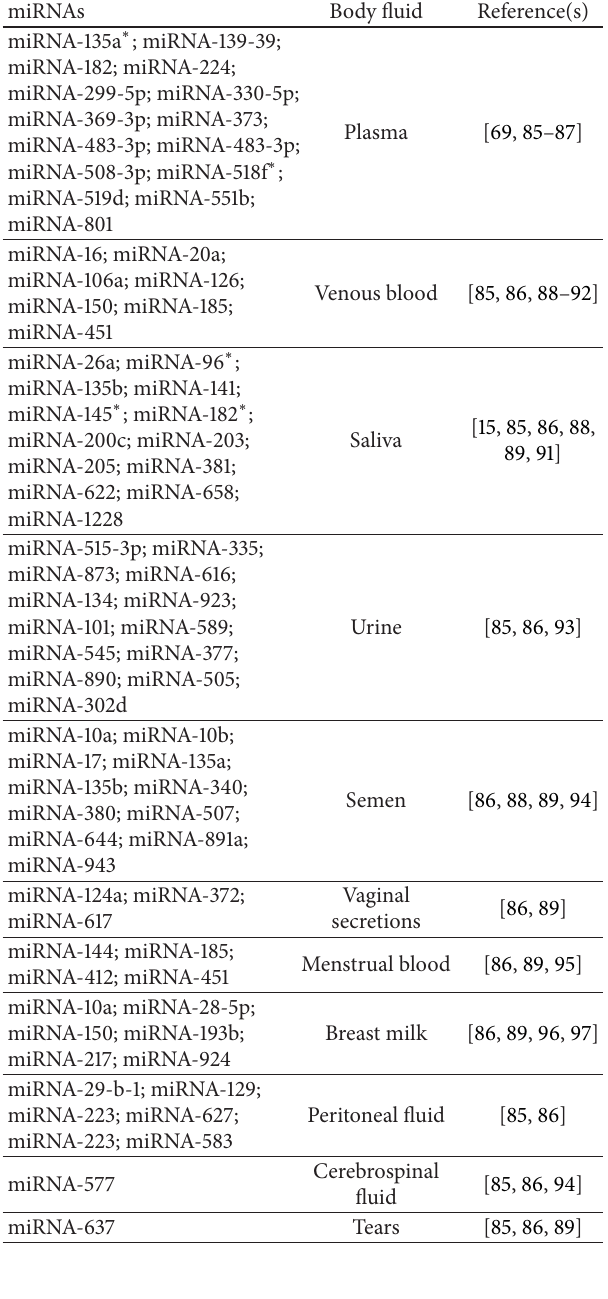
Table 1: miRNAs expression in body